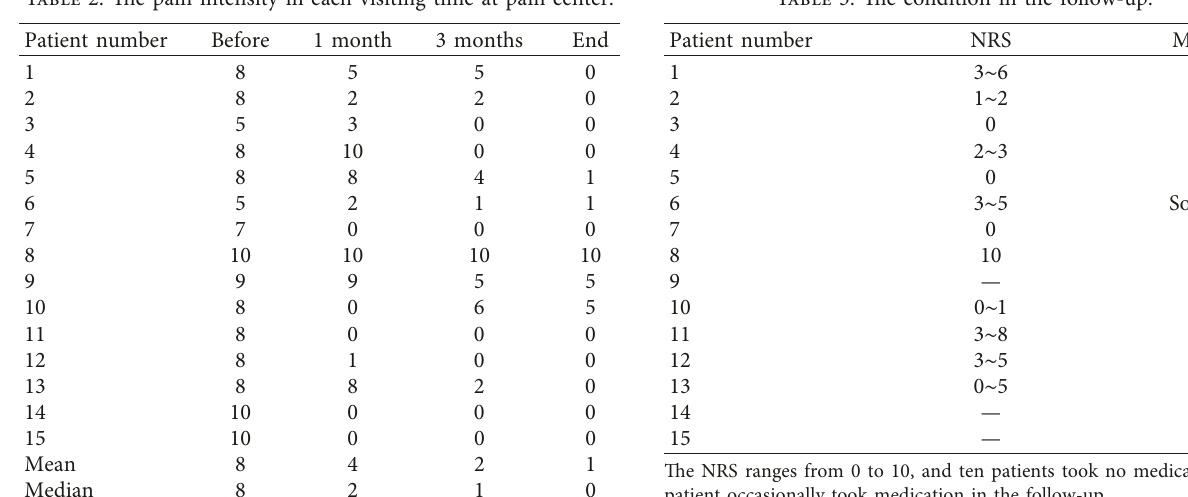
Table 3: The condition in the